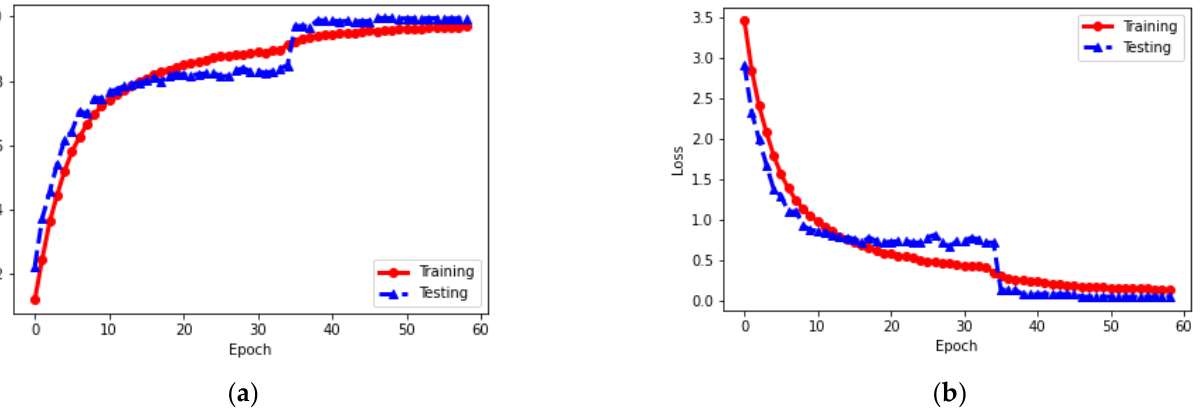
Figure 3. Performance accuracy and loss curves over epoch on the IMDB62 dataset: ( a ) accuracy, ( b ) loss.